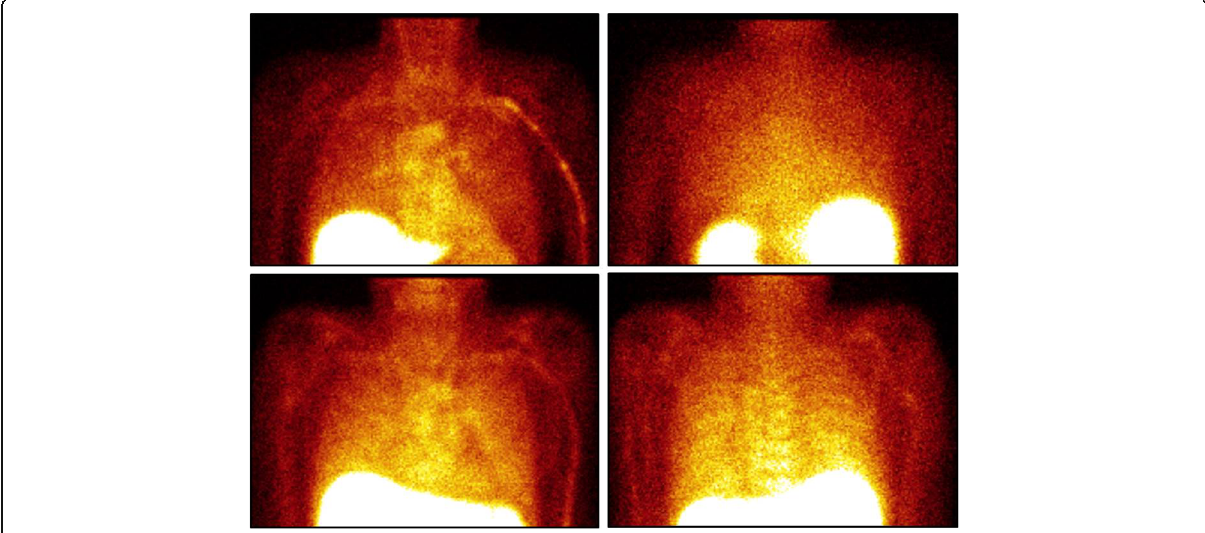
Fig. 1 99mTc-HYNIC-IL-2 scintigraphy. Upper row images: anterior (left) and posterior (right) static view of a patient without rejection, showing intense uptake in the liver and moderate uptake in the mediastinum/blood pool. Lower row images: anterior (left) and posterior (right) static view of a patient with rejection, showing intense uptake in the liver, moderate uptake in mediastinum/blood pool, and increased uptake in the basal and posterior parts of the lungs (uptake equal to